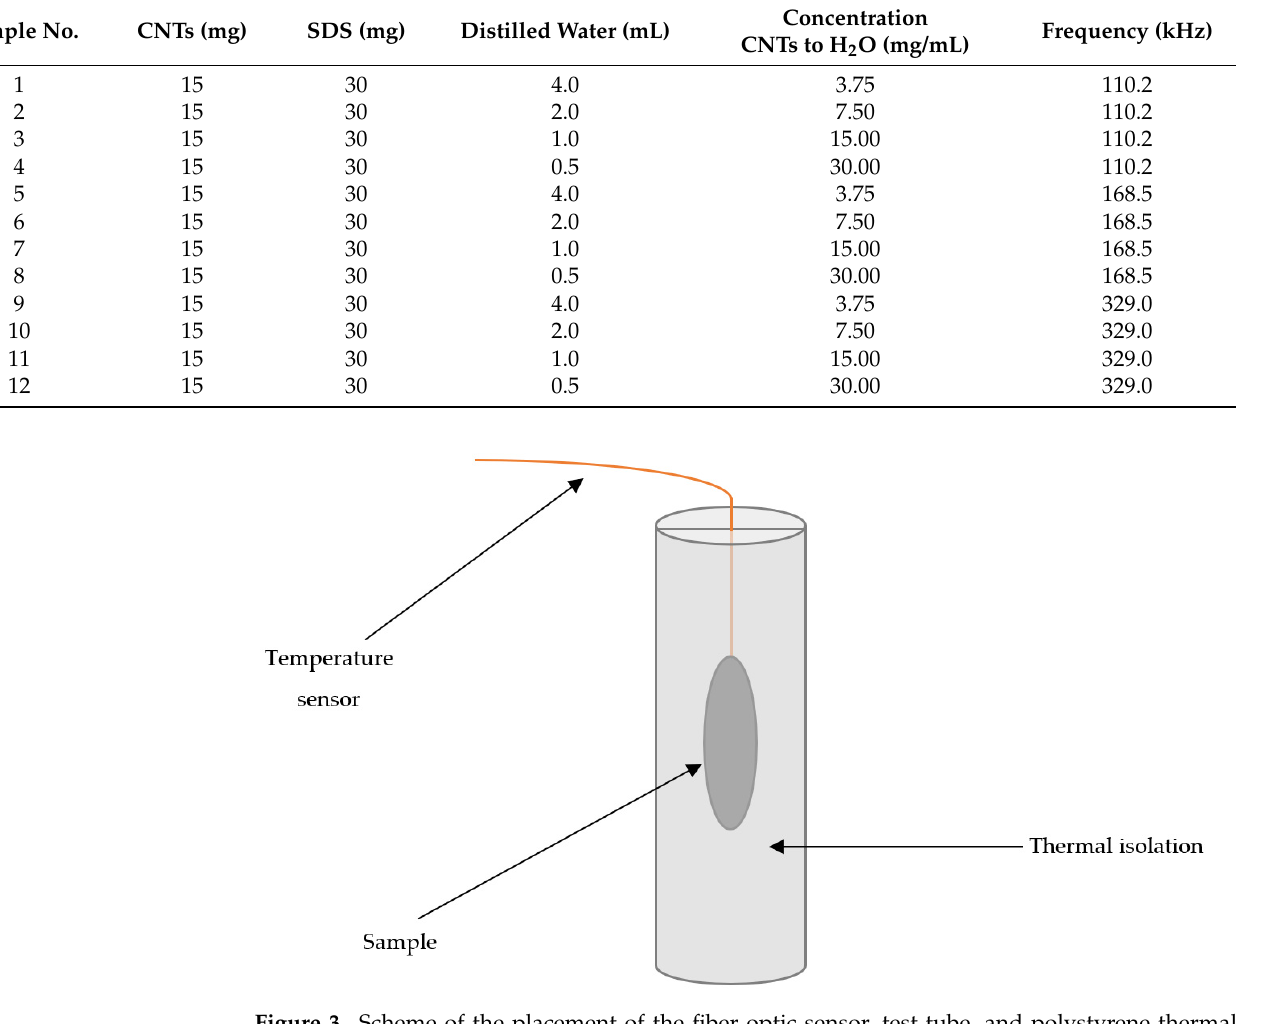
Figure 3. Scheme of the placement of the fiber optic sensor, test tube, and polystyrene thermal insulation used during the temperature measurements.